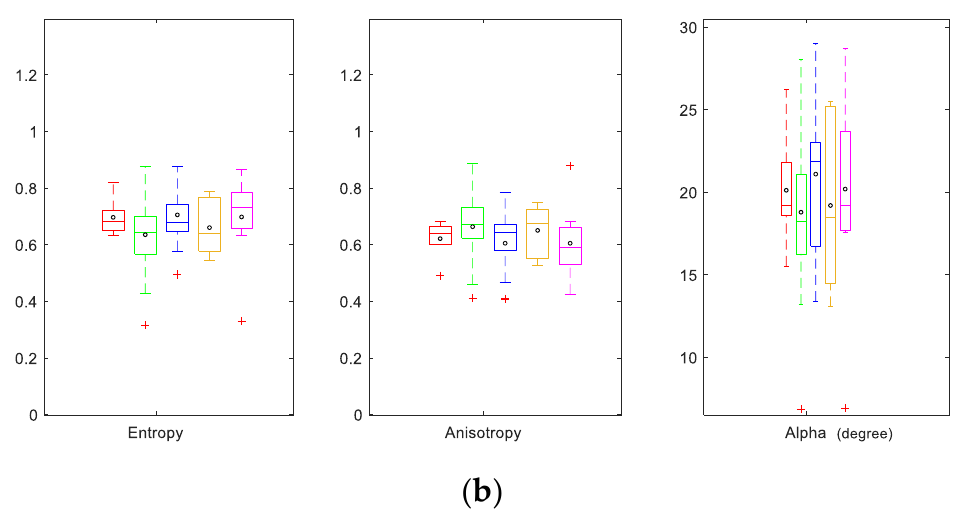
Figure 3. Boxplots presenting the variations in ( a ) backscatter coefficients VV, VH, and VV-VH; ( b ) decomposition parameters entropy, anisotropy, and alpha among different rock types. The black circle with each box is the mean value.